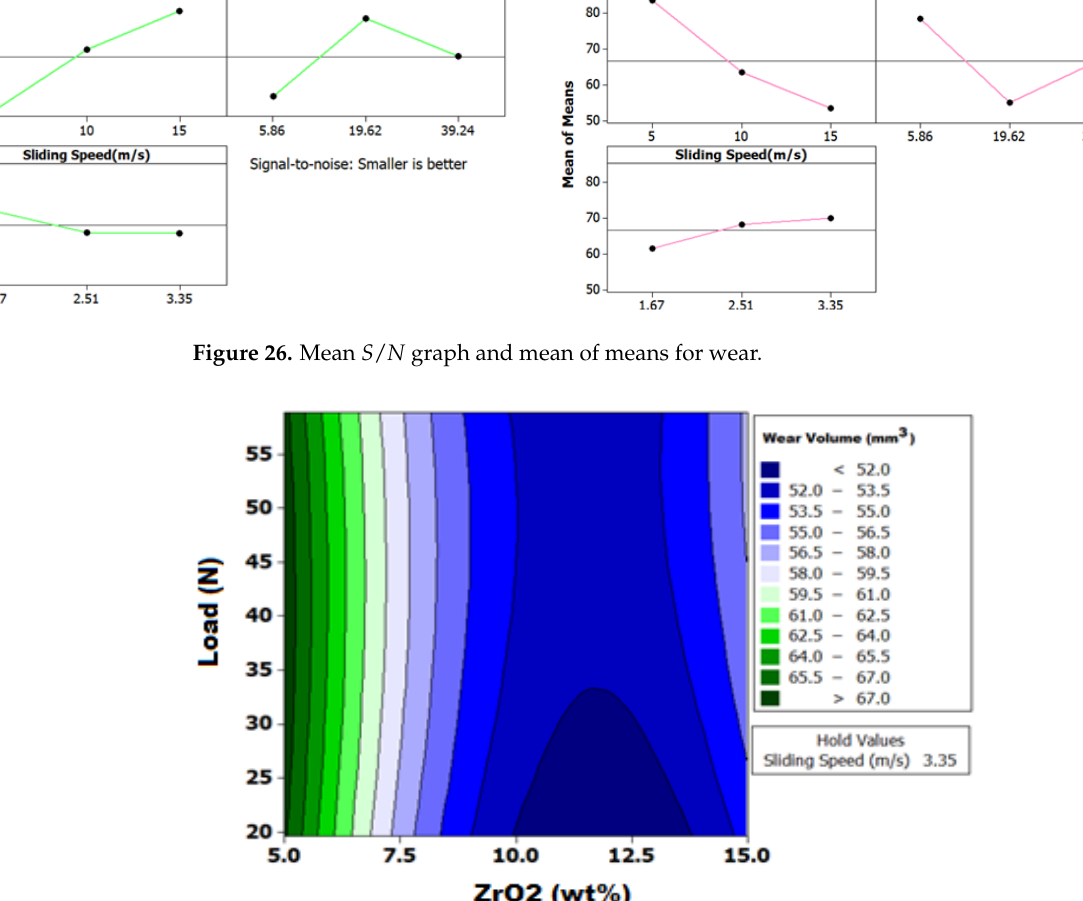
Figure 27. Contour plot for wear (mm 3 ) V/s ZrO 2